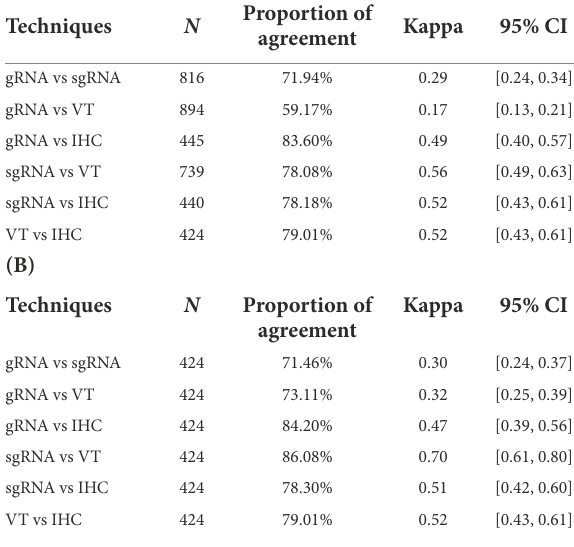
TABLE 3 Qualitative assessment of the techniques used in the experimental studies calculated on (A) the entire dataset or (B) selecting the samples analysed by all